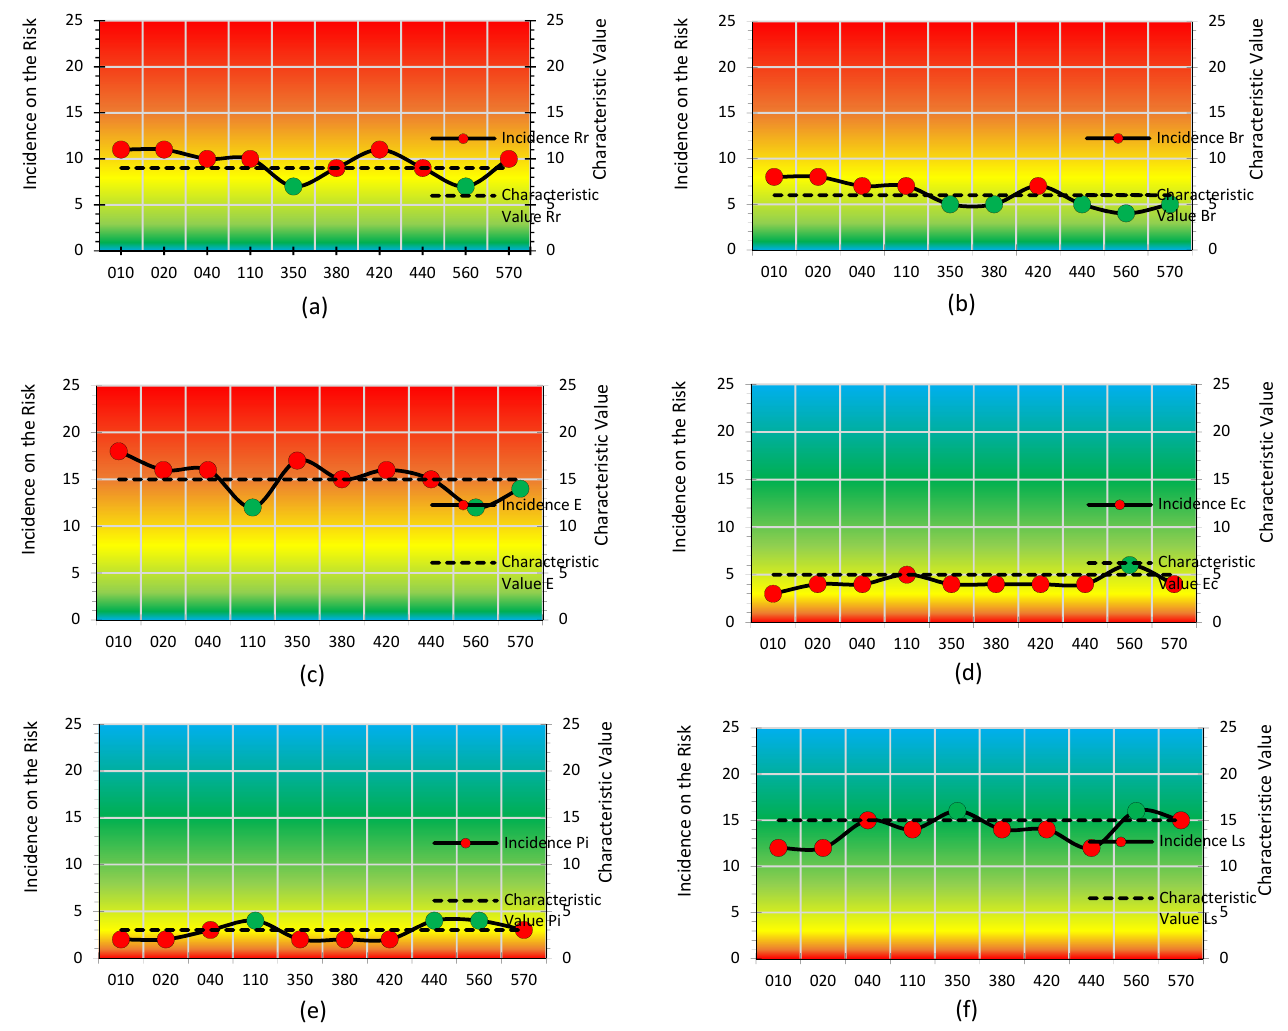
Figure 9. Cvs of Incidence of the denominator parameters. ( a ) Risk Assessment for Relative Risk; ( b ) Risk Assessment for Border Risk; ( c ) Risk Assessment for Exposition Level; ( d ) Risk Assessment for Economic Capacity; ( e ) Risk Assessment for Participative Interest; ( f ) Risk Assessment for Level of Satisfaction.